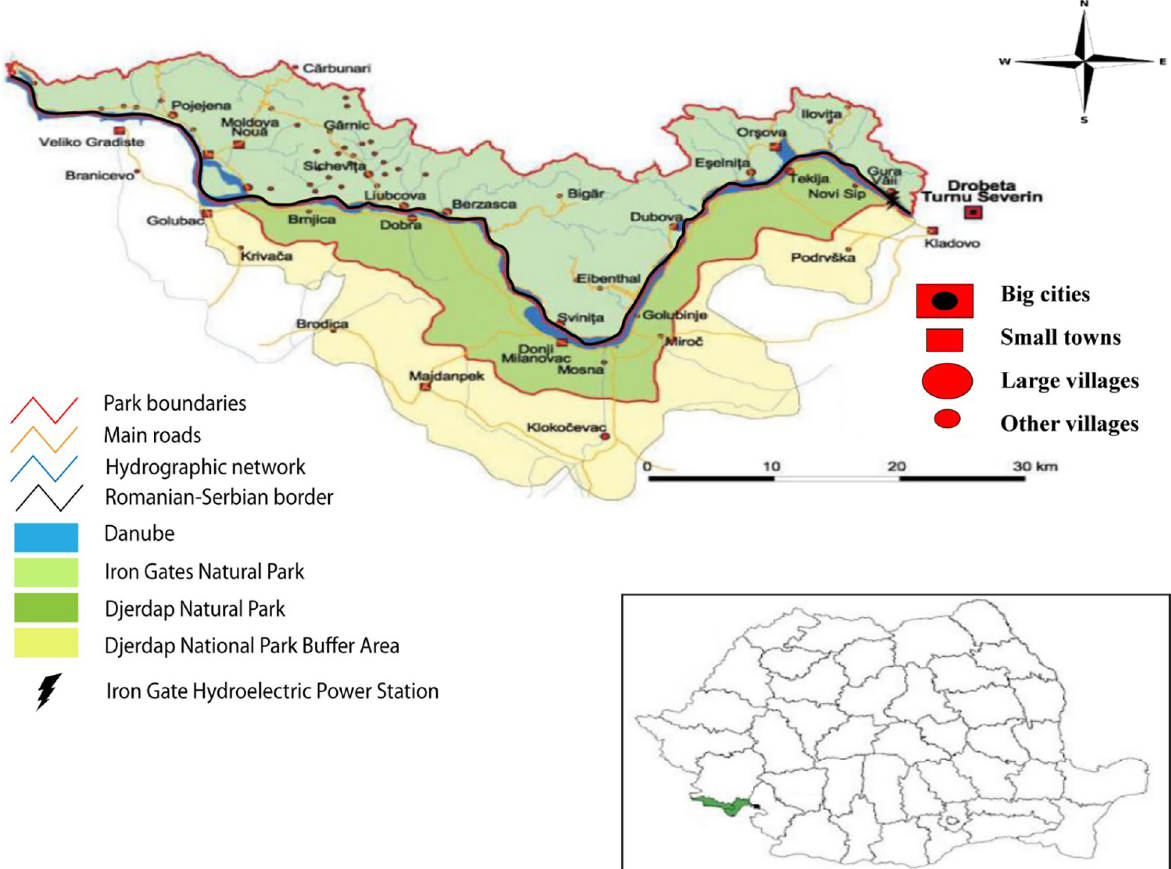
Fig. 2. Location of the Danube Gorge–Iron Gates region (after Pătroescu, Nec ș uliu 2008 with modifications). Source: own